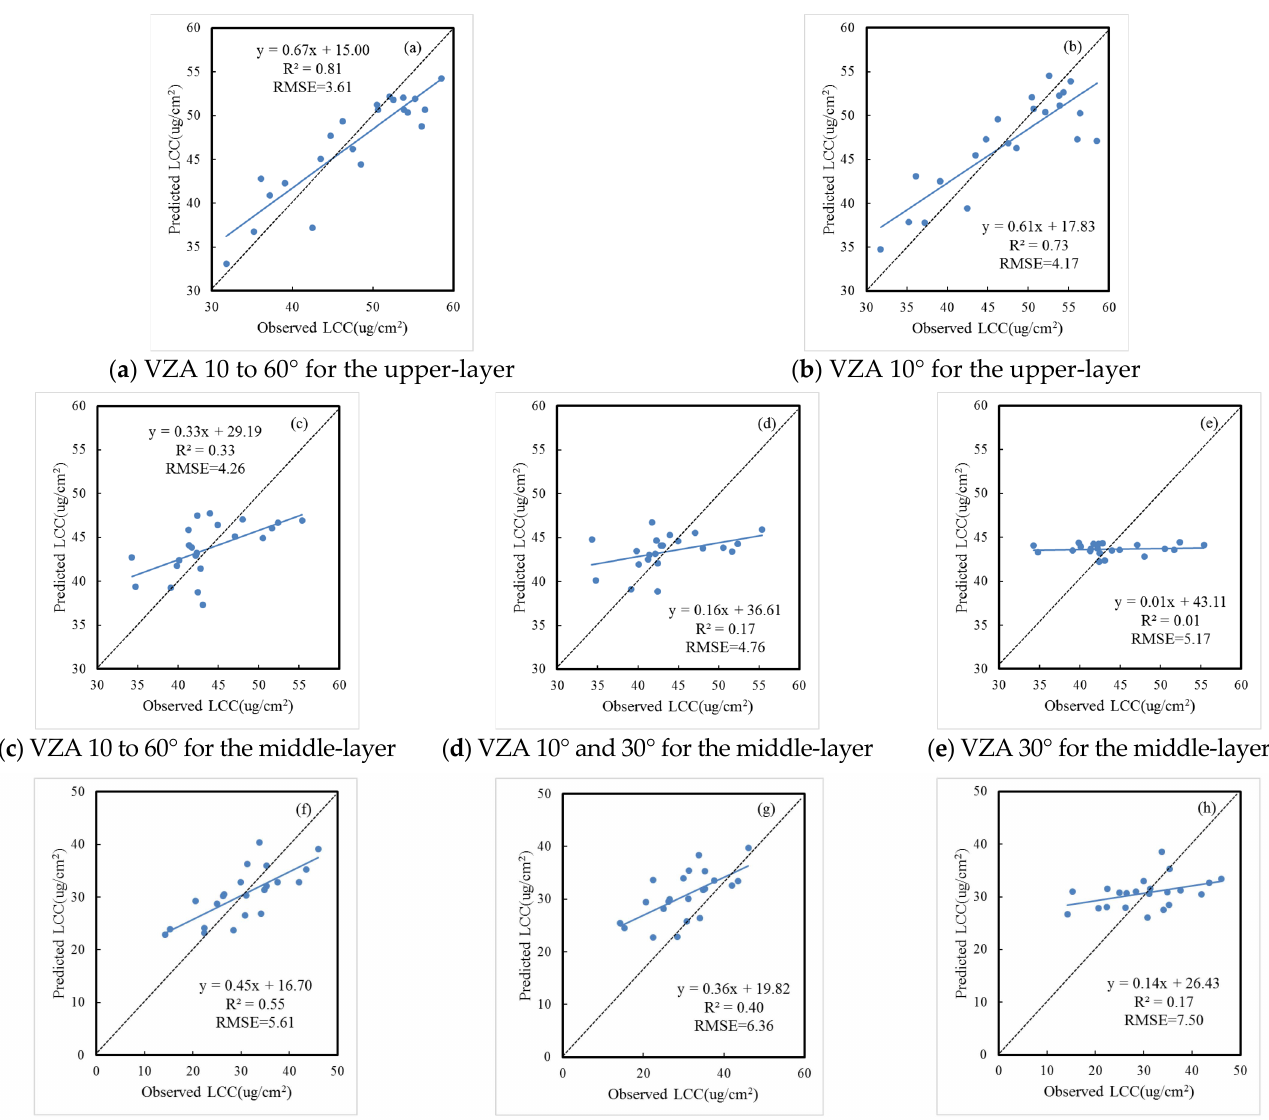
Figure 3. Comparison of the predicted and observed leaf chlorophyll content based on the TCARI using different VZA combinations for the upper-, middle-, and bottom-layers. ( a ) VZA 10 to 60° for the upper-layer. ( b ) VZA 10° for the upper- layer. ( c ) VZA 10 to 60° for the middle-layer. ( d ) VZA 10° and 30° for the middle-layer. ( e ) VZA 30° for the middle-layer.